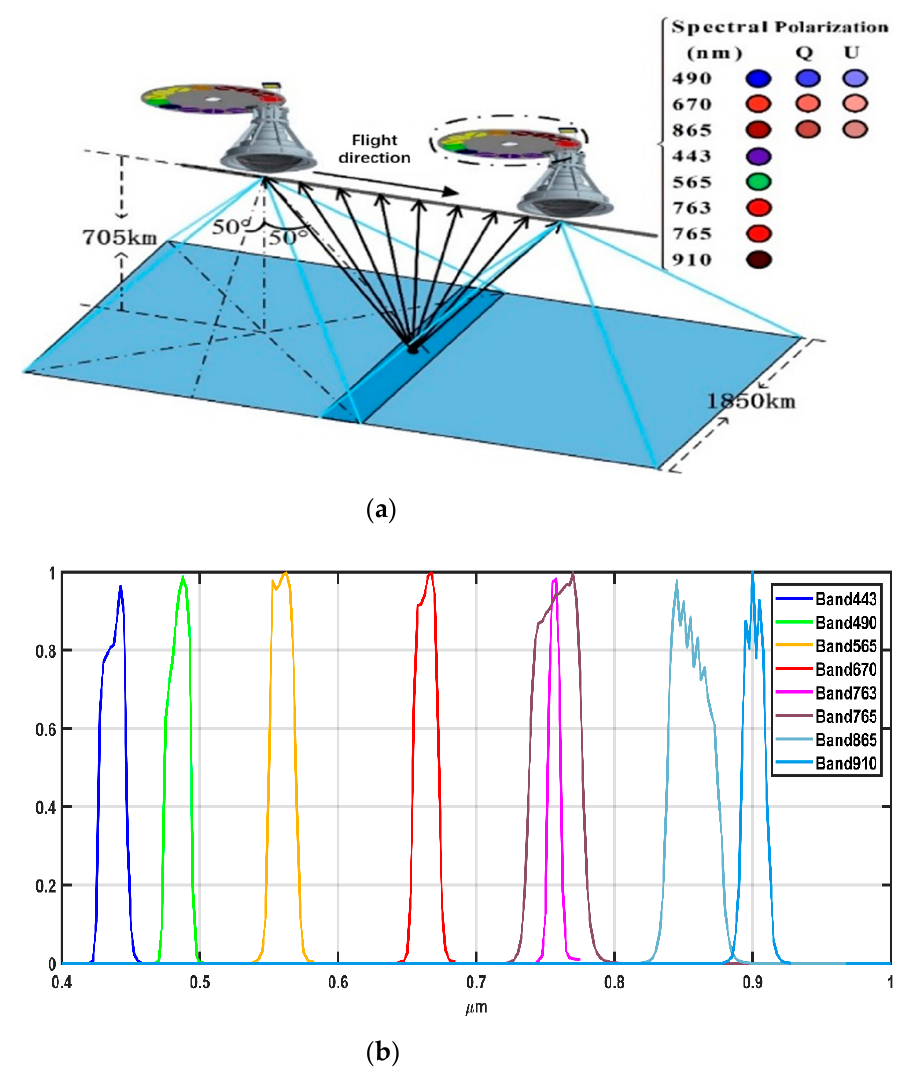
Figure 1. ( a ) In-flight working principle of DPC; ( b ) spectral response function of all DPC bands. Table 1. The parameters of the DPC on GF-5A.